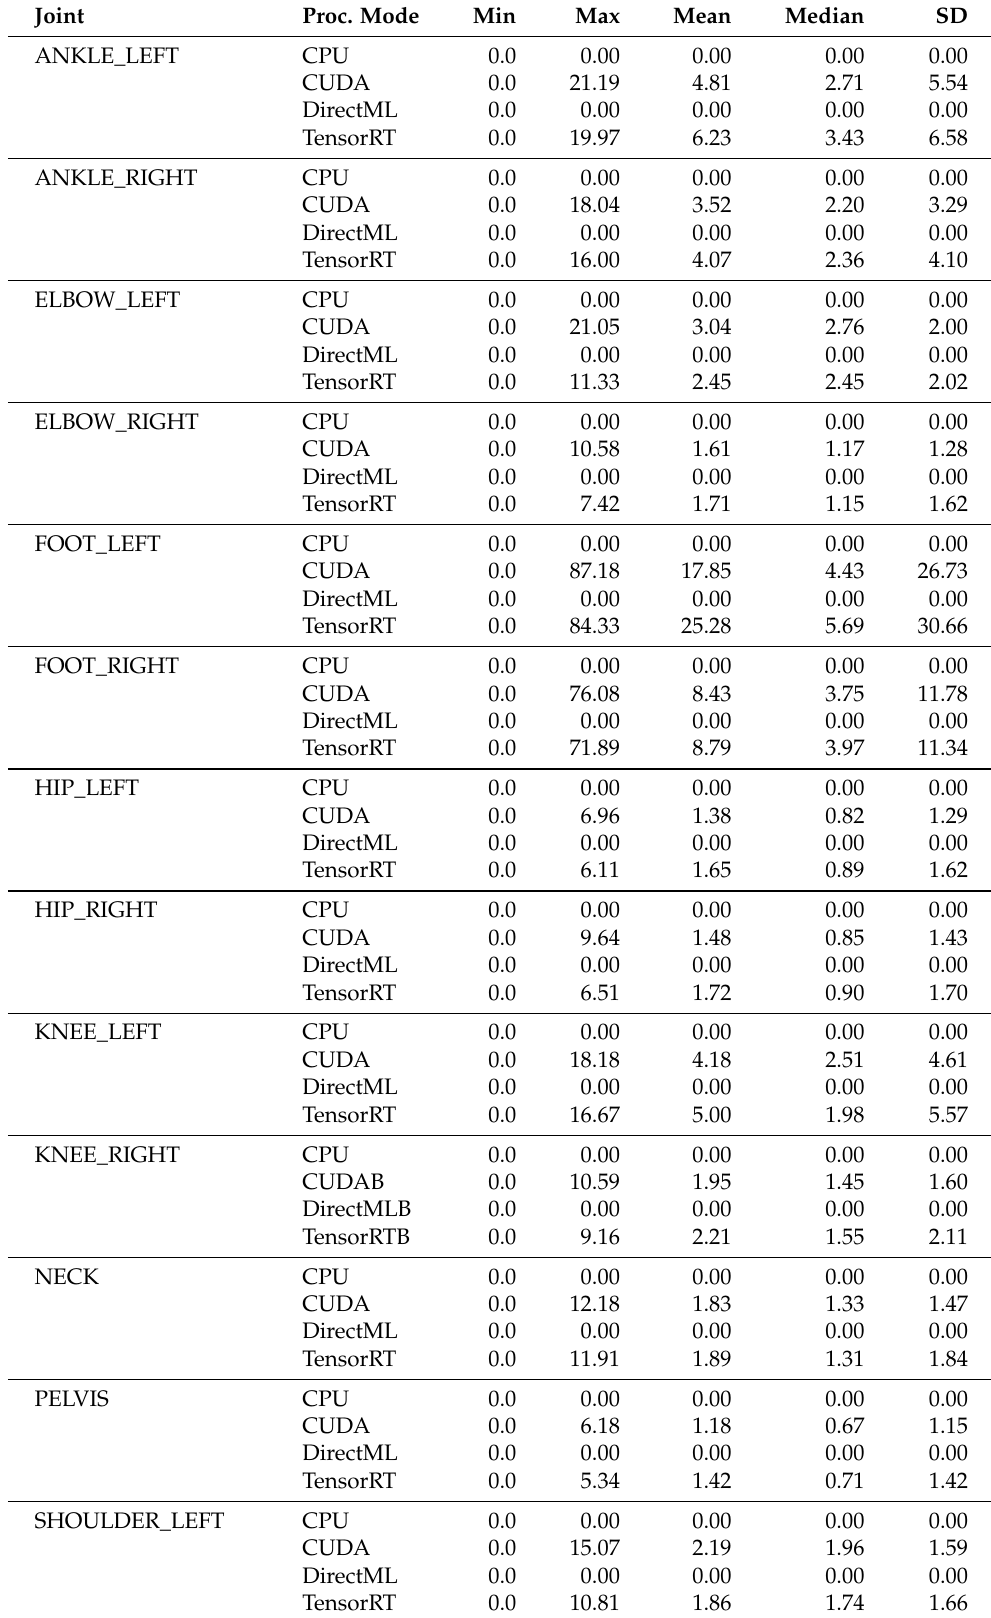
Table A3. Euclidean distances for each joint and processing mode. All values are in